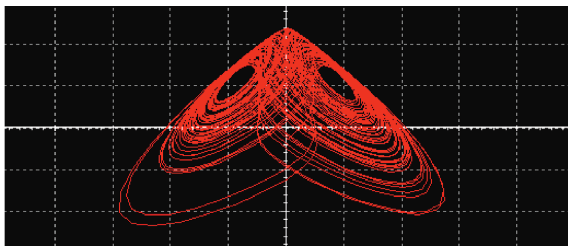
Figure 20: ( y, z ) space portrait of the Multisim simulation of equations (54)–(56).